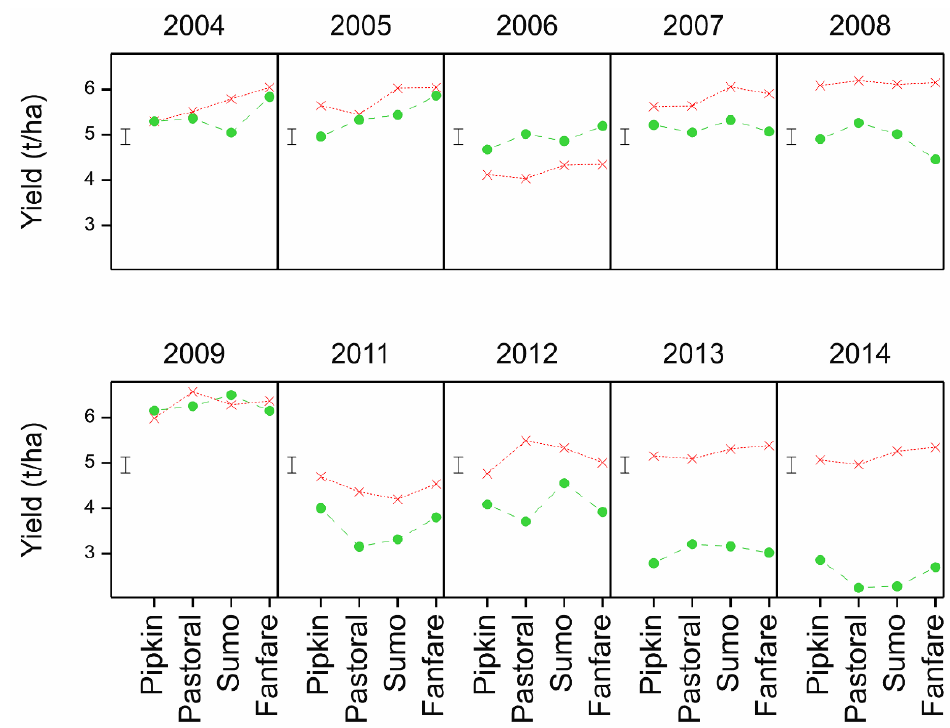
Figure 3. Overall and yearly mean yields of core set cultivars for inversion (red) and non-inversion (green) tillage from 2004 to 2014. The bar shows the size of the SED for the interaction between cultivar and tillage type.